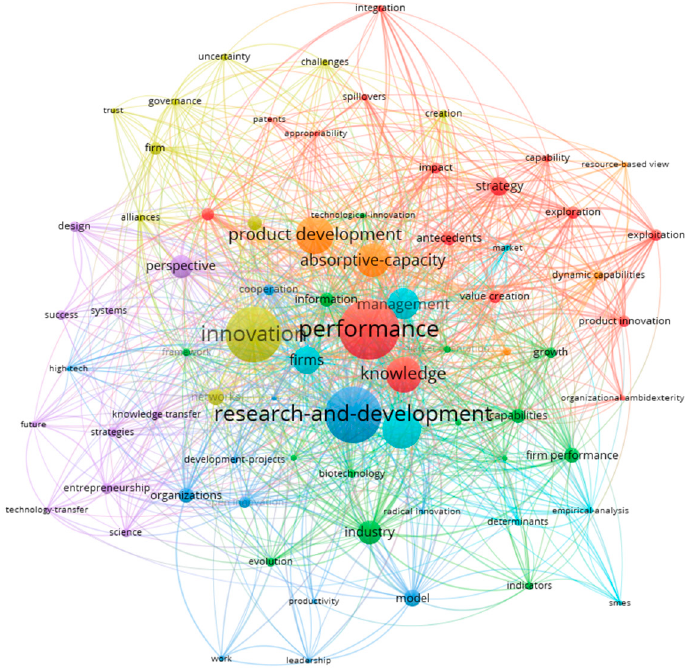
Figure 4. VOS Viewer: keywords from the R&D Management Journal. There were seven clusters detected in this journal; the total number of keywords was 74.